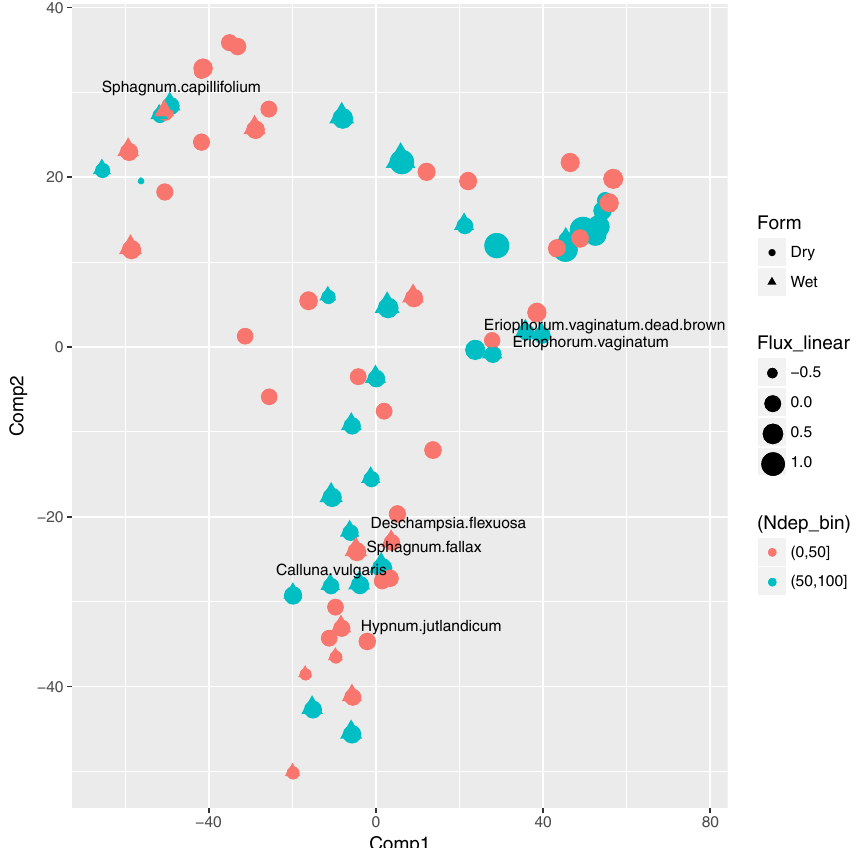
Figure 7. Biplot showing the scores for each chamber location for the first two PLS components. The first two PLS components represent the orthogonal indices of vegetation species composition which are the best linear predictors of mean N 2 O flux at each chamber location. The loadings for the important plant species are superimposed, indicating which species contribute most to the components. The data are grouped by nitrogen treatment form (symbol shape) and dose (symbol colour); symbol size is proportional to the magnitude of the mean N 2 O